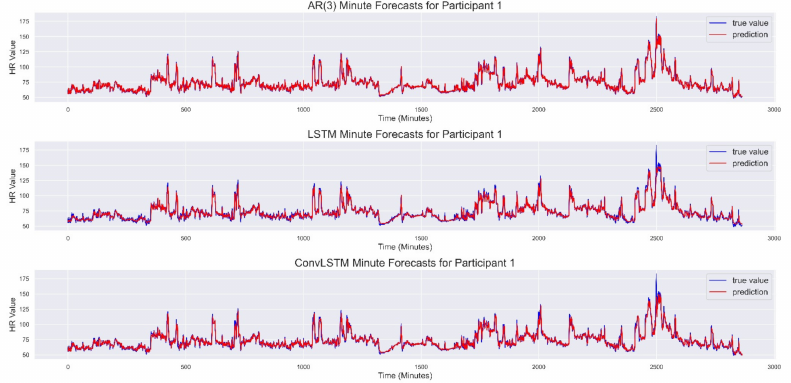
Figure 1. Forecast results for Participant 1. ( Top ) Results obtained from the AR(3) model. ( Center ) Results obtained from the Stacked LSTM architecture. ( Bottom ) Results obtained from the ConvLSTM architecture. AR(3): Autoregressive Model of order 3; LSTM: Long Short-Term Memory Network; ConvLSTM: Convolutional Long Short-Term Memory Network.